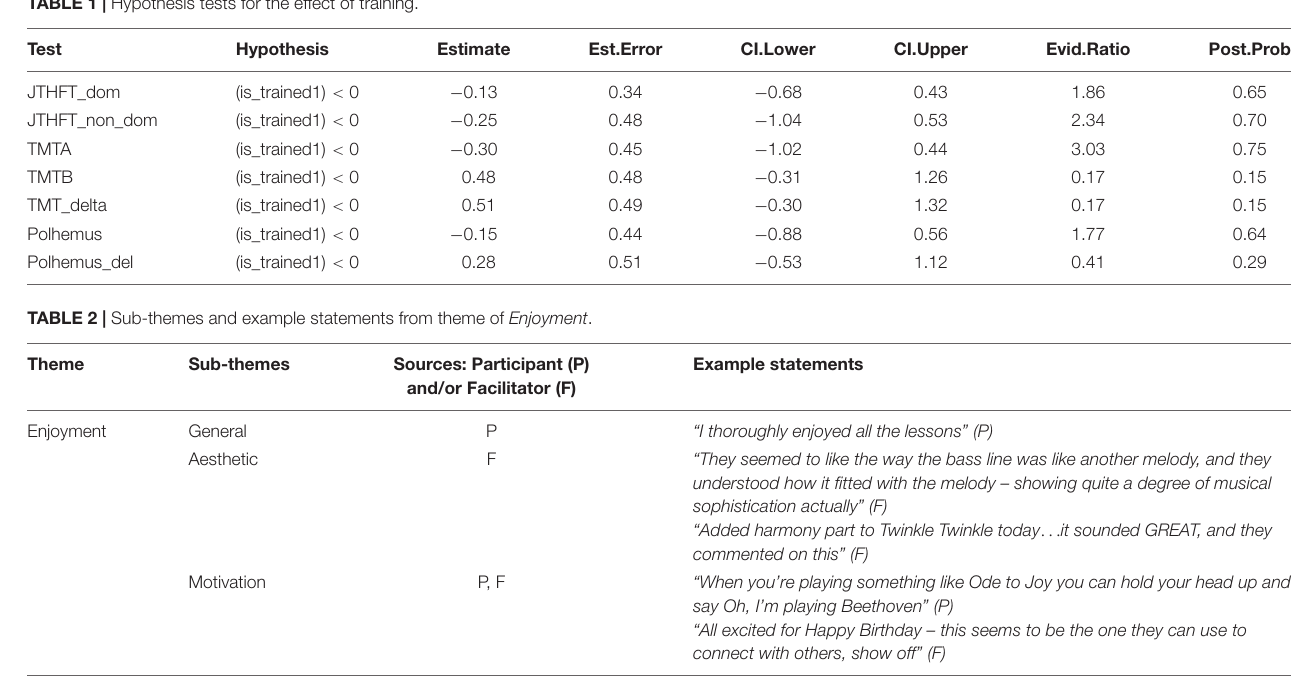
TABLE 3 | Sub-themes and example statements from theme of Intellectual Challenge .